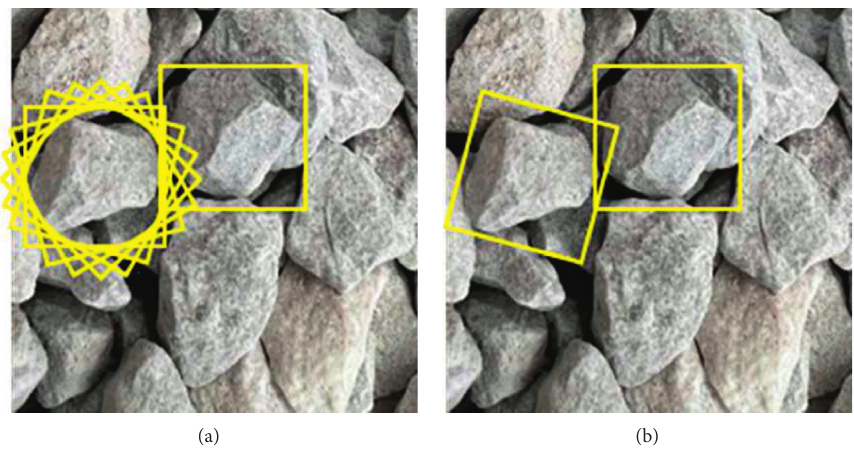
Figure 5: (a) The merges results of all rotation; (b) the average window of particles.